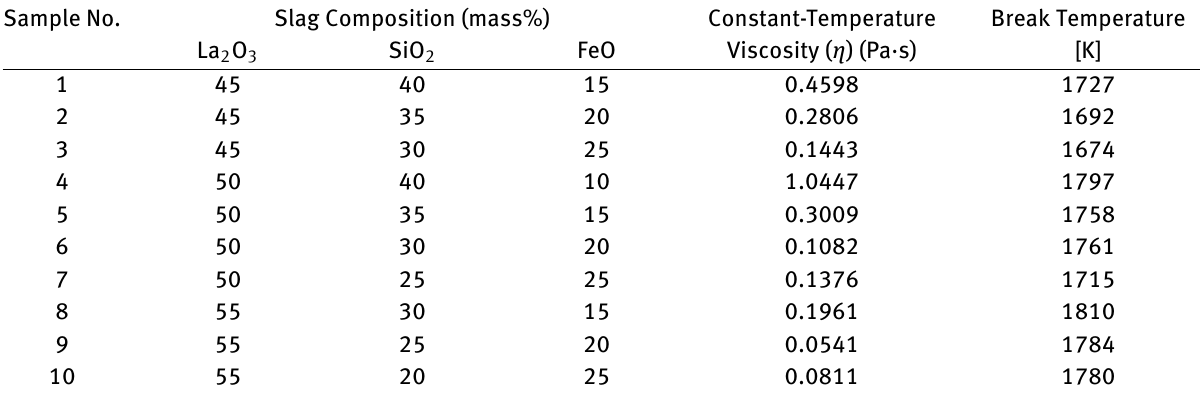
Table 1: Constant-Temperature Viscosity and Break Temperature of La 2 O 3 -SiO 2 -FeO Ternary Basic Slag. Sample